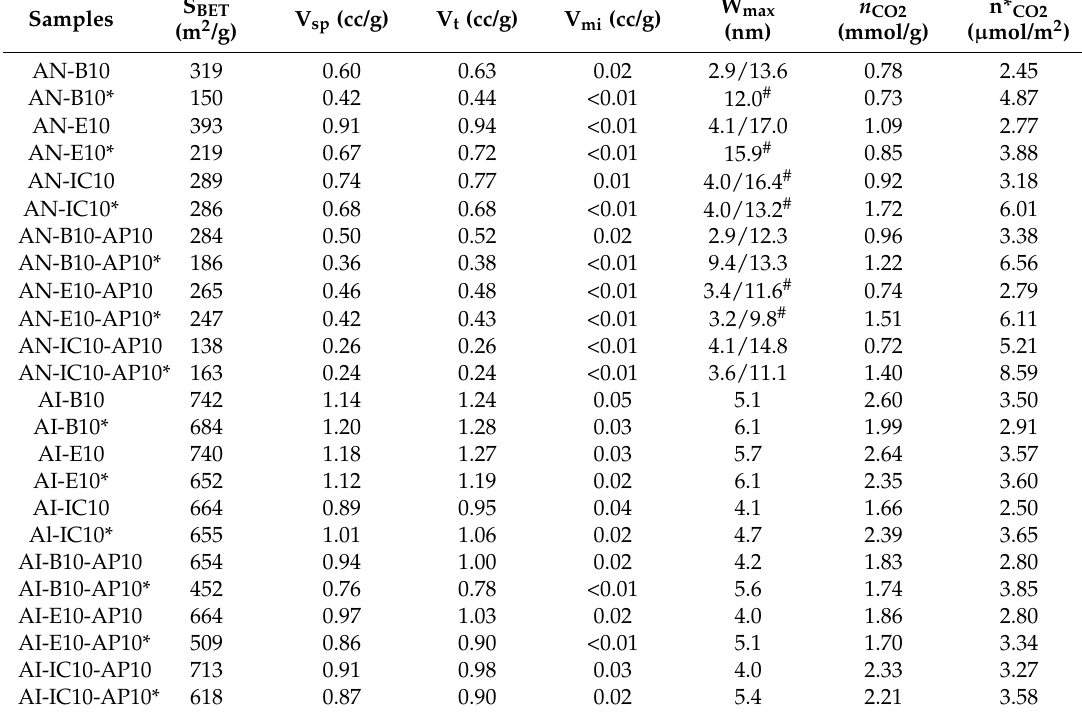
Table 1. Adsorption parameters obtained for the alumina–silica samples studied.